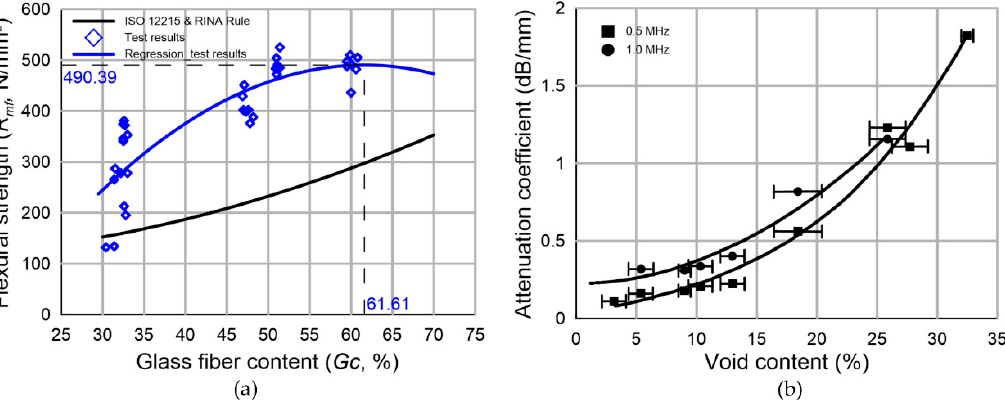
Figure 2. Laminate properties: ( a ) flexural strength with respect to the glass fiber content ( G c ) [14] and ( b ) attenuation coefficient with respect to the void content; Reprinted with permission from ref. [13]. 2020 Daekyun Oh.